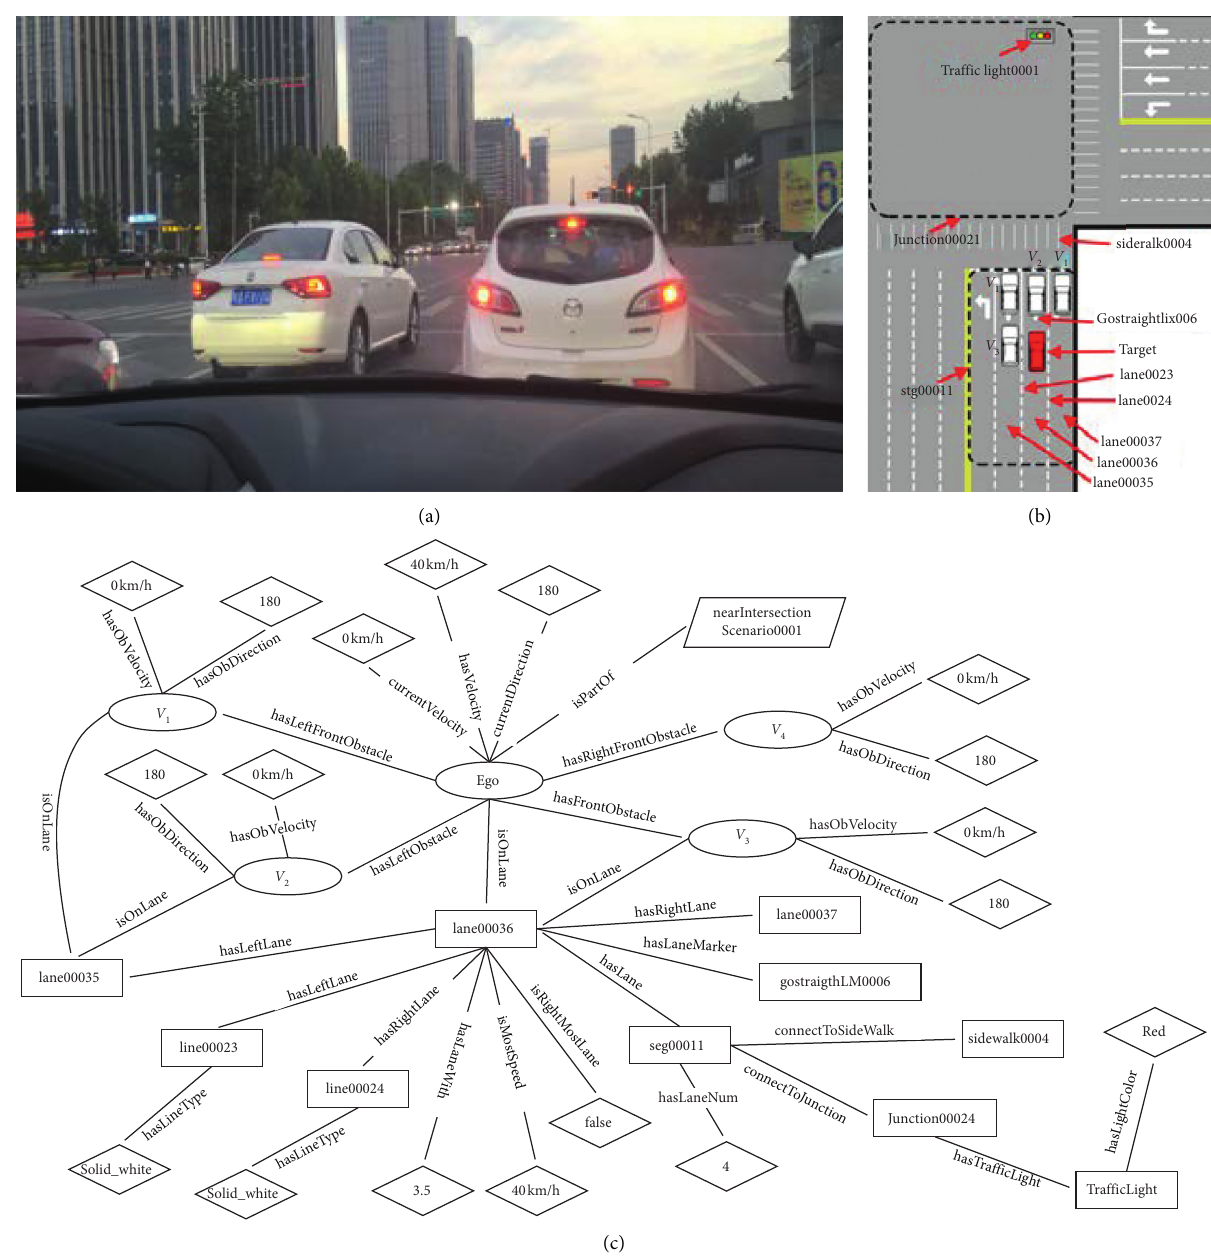
Figure 6: Scene modeling: (a) real-traffic scenario; (b) concrete driving scene; (c) semantic description of the concrete